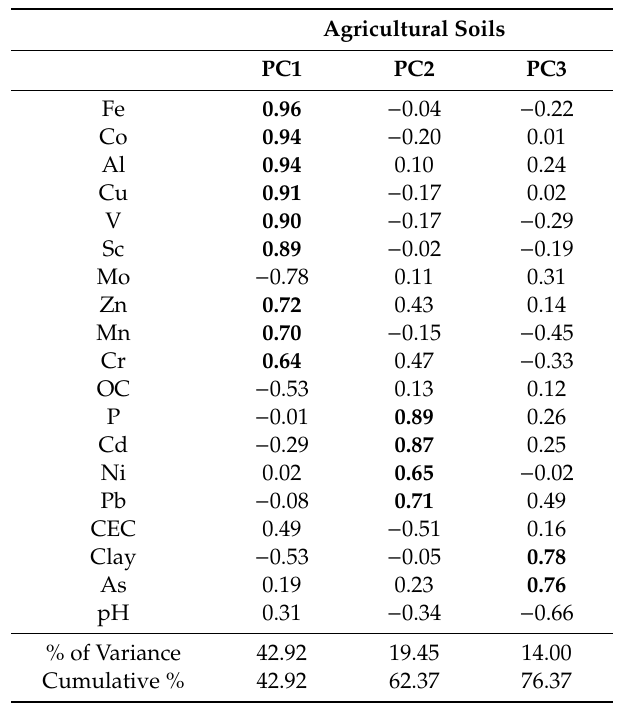
Table S1: Indices of pollution assessment for studied potentially toxic